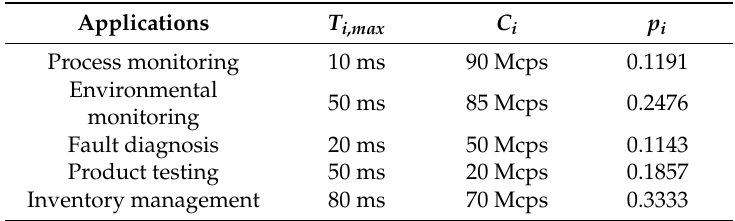
Table 2. Applications and